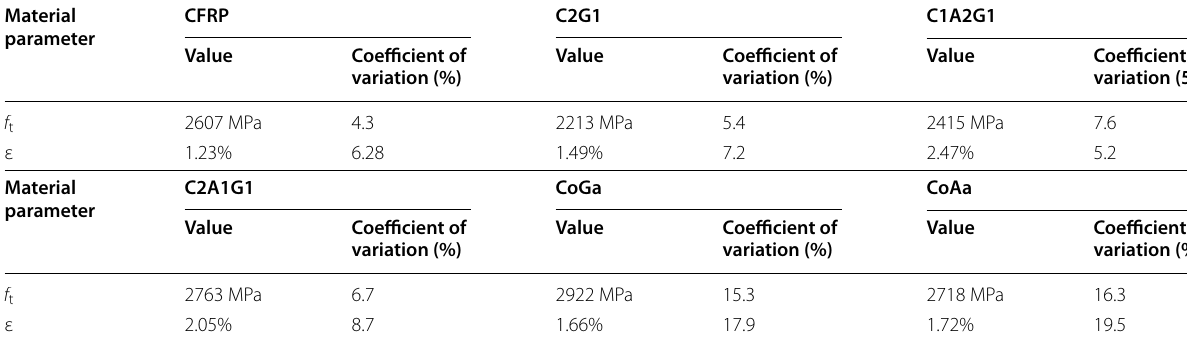
Table 3 Material properties of hybrid fiber